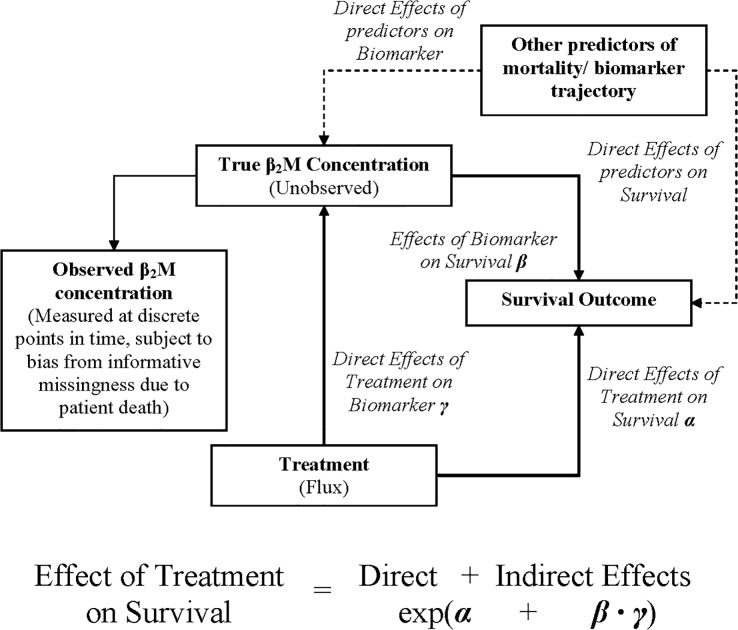
Conceptual depiction of the Joint Modeling Framework.A joint model is an analytical method for the simultaneous estimation of treatment effects on survival outcomes, the effects of treatment on the concentration of a biomarker over time (trajectory function) and the effects of the latter on survival. As the true biomarker level is unobserved, a JM has to reconstruct its trajectory before these effects can be estimated. Other factors may affect survival either directly or indirectly (through the biomarker concentration) and they can be used to adjust a JM and thus reduce residual confounding. One possible interpretation of the fitted joint model effects on survival assigns direct treatment effects (not associated with changes in the biomarker trajectory, α) and indirect treatment effects (associated with changes in the biomarker concentration, given by the product of β and γ). Hence, the overall treatment effect in the Hazard Ratio scale is the (exponentiated) sum of direct and indirect effects. This effect is usually numerically similar to the one estimated by a Cox model.